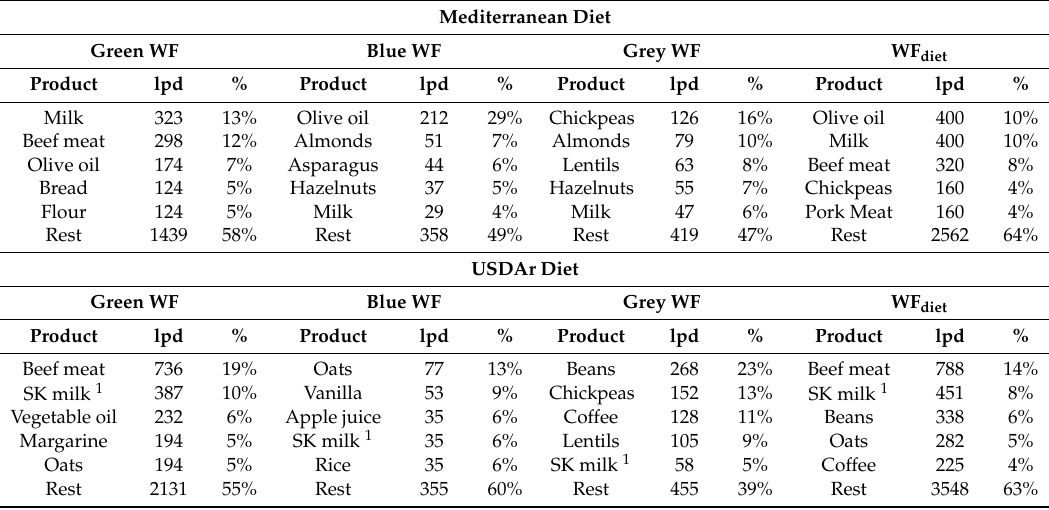
Table 2. The five products that contribute the most in L/person and day (lpd) and % to the green, blue, grey and total WF diet for the Mediterranean and USDAr diets in the